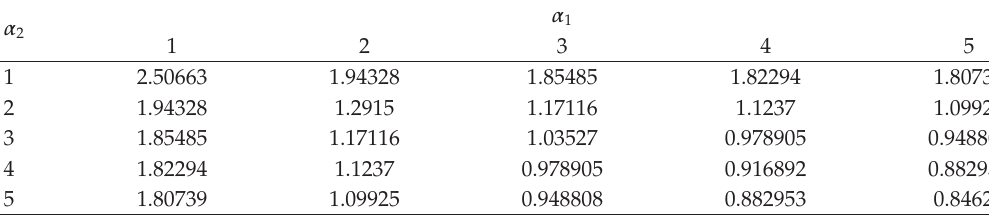
Table 4: The moments μ 2:2 arising from inid Exponentiated Frechet r.v.’s. using (cid:2) 3.3 (cid:3) or (cid:2) 3.5 (cid:3) . α